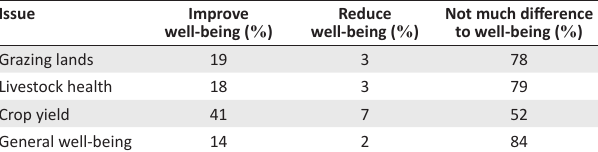
TABLE 4: The percentage of respondents ( n = 166) who regarded the effect of control measures against Tithonia diversifolia on a particular issue as either bringing about improvements or reductions in their well-being, or who had no opinion on the issue, in the Copperbelt Region,